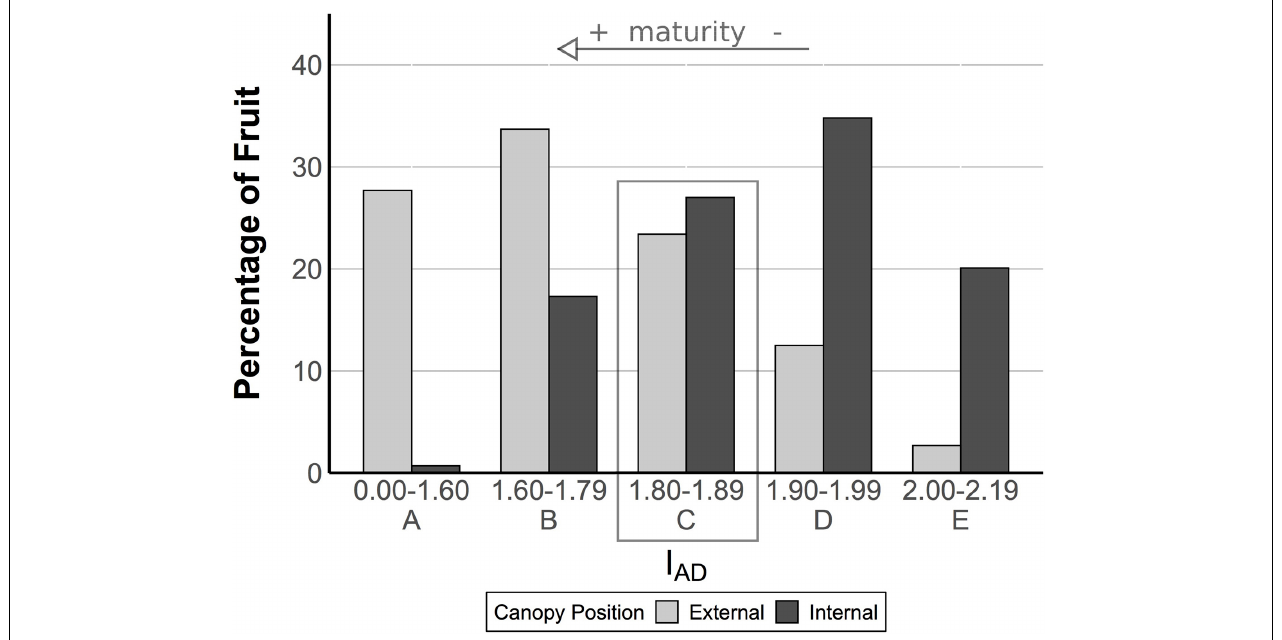
FIGURE 1 | Fruit from the two canopy positions have an overlapping distribution of I AD . The I AD provides a measure of chlorophyll-a content in the fruit based upon the difference between the absorbance of the chlorophyll-a peak at 670 nm and the spectrum background at 720 nm. It has been used as a proxy for maturity in pome fruits (see arrow). In this experiment, we analyzed fruit quality by I AD class. Within class C (see box), fruit were ostensibly of similar maturity, but our analysis of fruit quality revealed different postharvest outcomes, suggesting external fruit were more mature. We targeted class C fruit for a transcriptome analysis to search for genes associated with these different postharvest